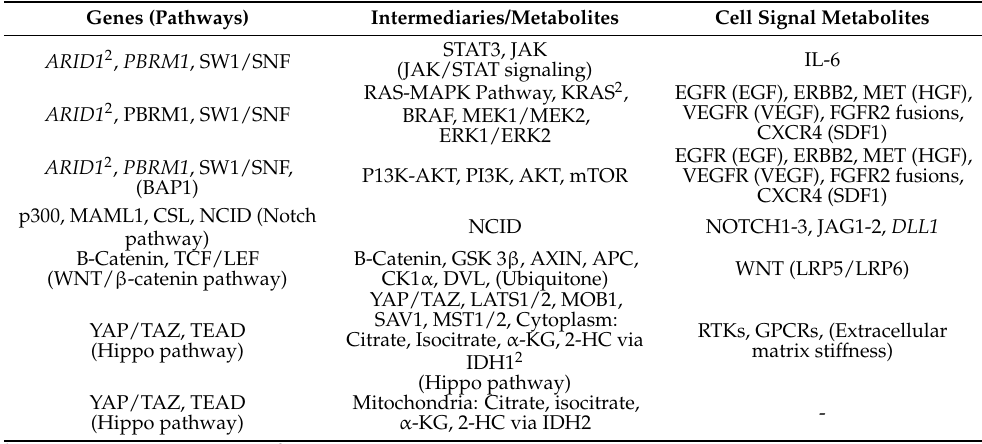
Table 1. Primary factors with metabolites in cholangiocarcinoma (CCA) 1 pathogenesis. Genes